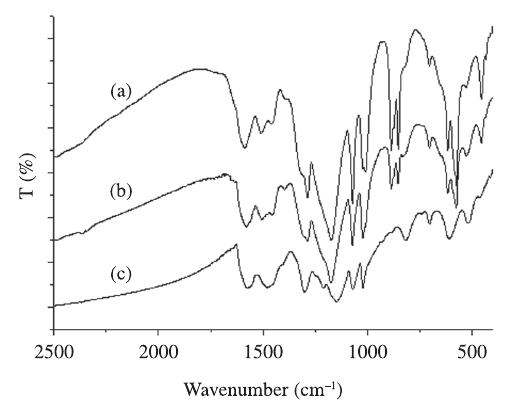
Figure 1. FTIR spectrum of (a) SPAN 3.0, (b) SPAN 2.0 and (c) SPAN 1.5.